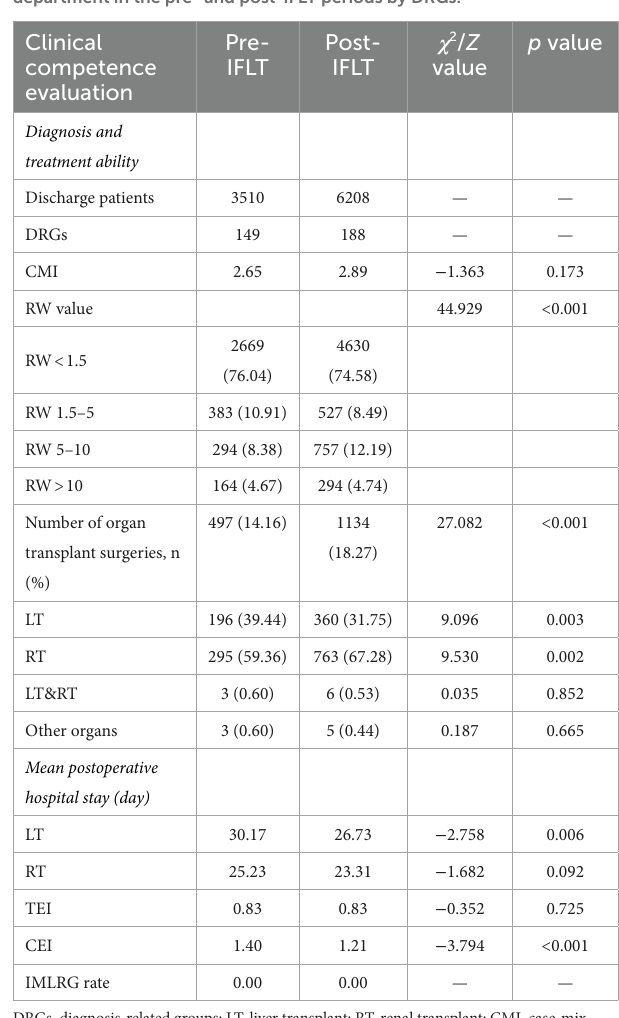
TABLE 4 Evaluation of clinical competence of the organ transplant department in the pre- and post-IFLT periods by